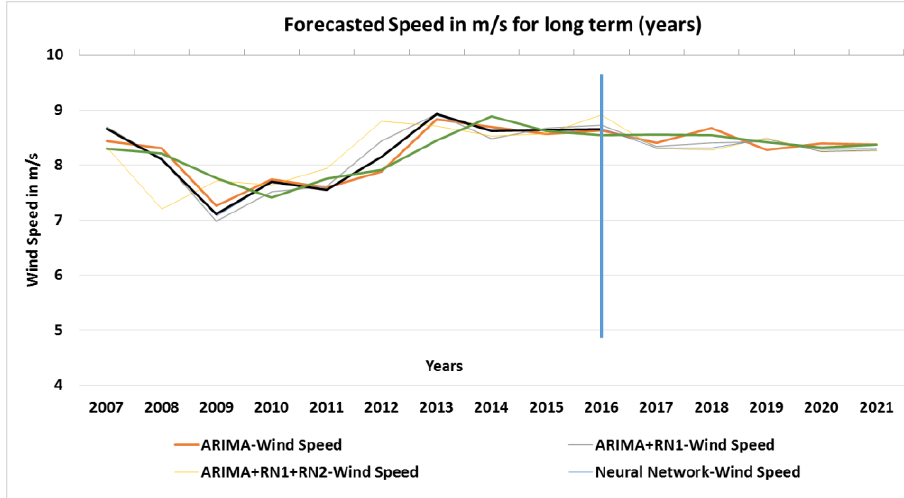
Figure 18. Estimated Speed in m/s for long-term forecast (years). Source: Authors.